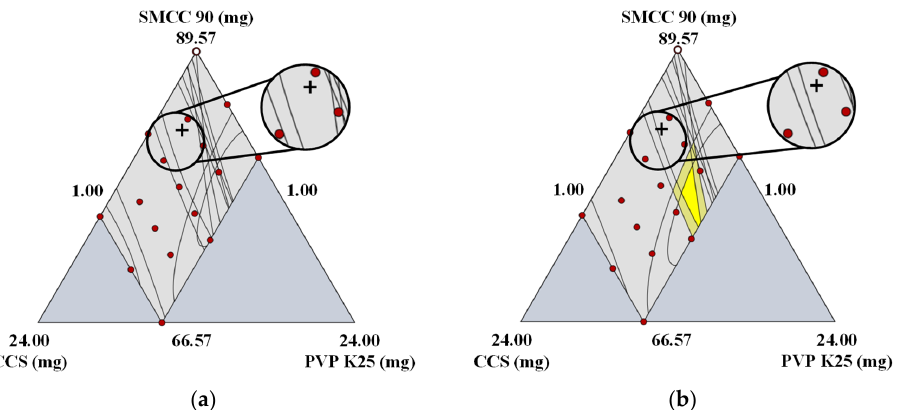
Figure 4. Design space variability resulting from changes in the manufacturer; ( a ) Design space using A3; ( b ) Design space using C4. The crosshair indicates the optimal setting of formulation development. (SMCC, silicified microcrystalline cellulose; CCS, croscarmellose sodium; PVP, polyvinylpyrrolidone).